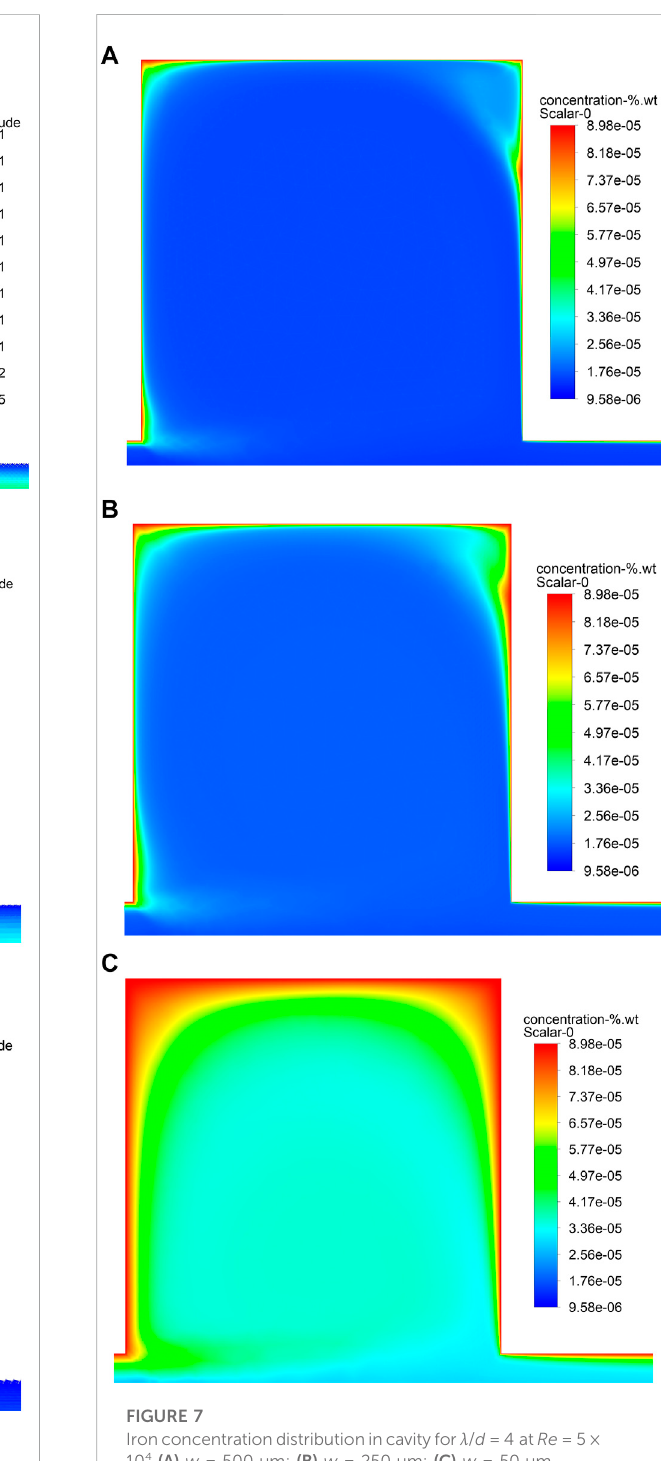
FIGURE 6 Velocity fi eld in cavity for λ / d = 4 at Re = 5 × 10 4 (A) w = 500 μ m; (B) w = 250 μ m; (C) w = 50 μ m.